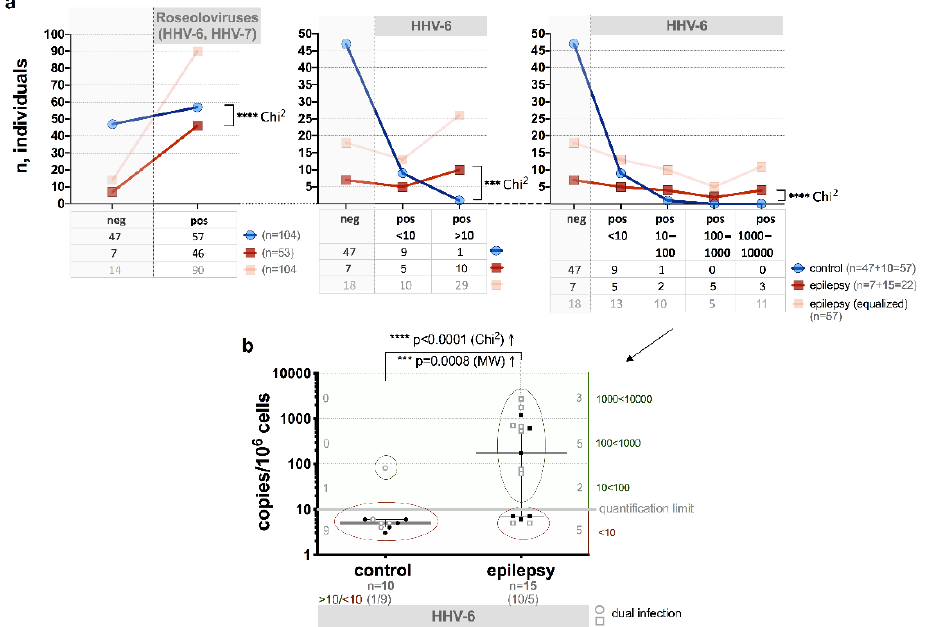
Figure 1. HHV-6 load in whole peripheral blood (WPB) of the patients with epilepsy (including cases with dual HHV-6 and HHV-7 infection) and control group individuals: ( a ) Comparison of frequency of HHV-6 positive (pos) and negative (neg) cases in epilepsy patients and control individuals; ( b ) comparison of viral load and frequency of HHV-6 positive epilepsy patients and control individuals, light symbols indicate cases with double HHV-6 and HHV-7 infection, with red ovals are marked low viral load ( < 10 copies / 10 6 cells) cases, with green ovals—elevated viral load ( > 10 copies / 10 6 cells) cases; asterisks in a represent a significance level of di ff erences between groups (*** p < 0.001, **** p < 0.0001). The frequency of HHV-6 load >10 copies/10 6 cells was detected in 66.7% (10/15) of the patients with epilepsy and in one out of 10 or 10% of the control group individuals ( p < 0.0001, Chi 2 ) both with